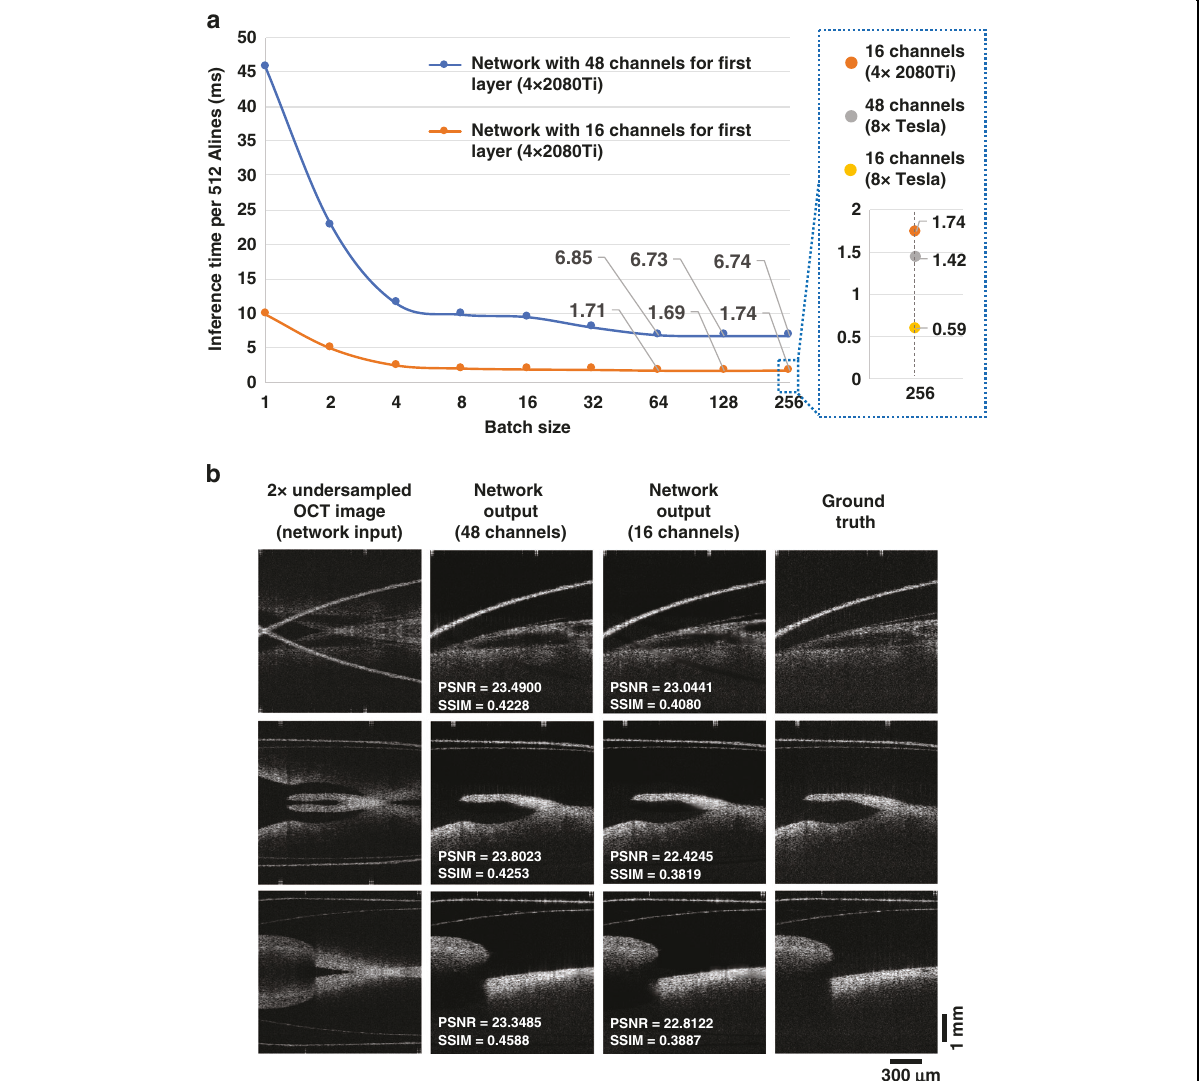
Fig. 5 DL-OCT inference time as a function of the B-Scan batch size for blind testing. a With increasing batch size, the average inference time per B-Scan (512 A-lines) rapidly decreases owing to the parallelizable nature of the neural network computation. The average inference time converged to ~6.73 ms per B-Scan for a batch size of 128. If the number of channels in the neural network ’ s fi rst layer is reduced from 48 down to 16, the average inference time further improved to ~1.69 ms per B-Scan. Our GPU memory size limited further reduction of the average inference time of DL-OCT. By using 8 NVIDIA Tesla A100 GPUs in parallel, the inference time was further reduced to ~1.42 ms and ~0.59 ms per B-scan for the 48- channel and 16-channel networks, respectively. All inference times were obtained by averaging 1000 independent runs, computed on a desktop computer (see “ Materials and methods ” section). b Sample fi elds-of-view are shown for network input, network output (using 48 channels vs. 16 channels in the fi rst layer), and ground truth images. PSNR and SSIM values are also displayed for each one of these fi